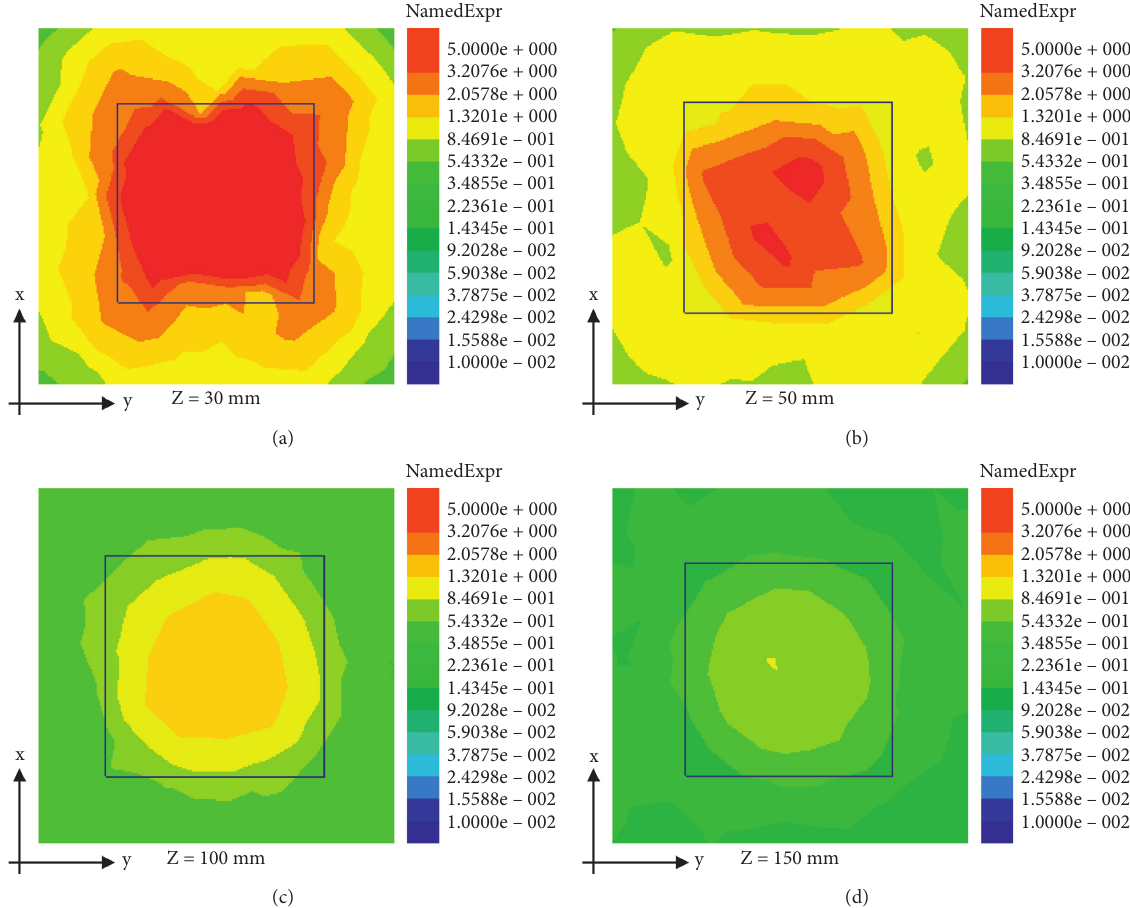
Figure 8: Simulated Ez distributions of the four-branch antenna at (a) Z � 30mm, (b) Z � 50mm, (c) Z � 100mm, and (d) Z � 150mm.